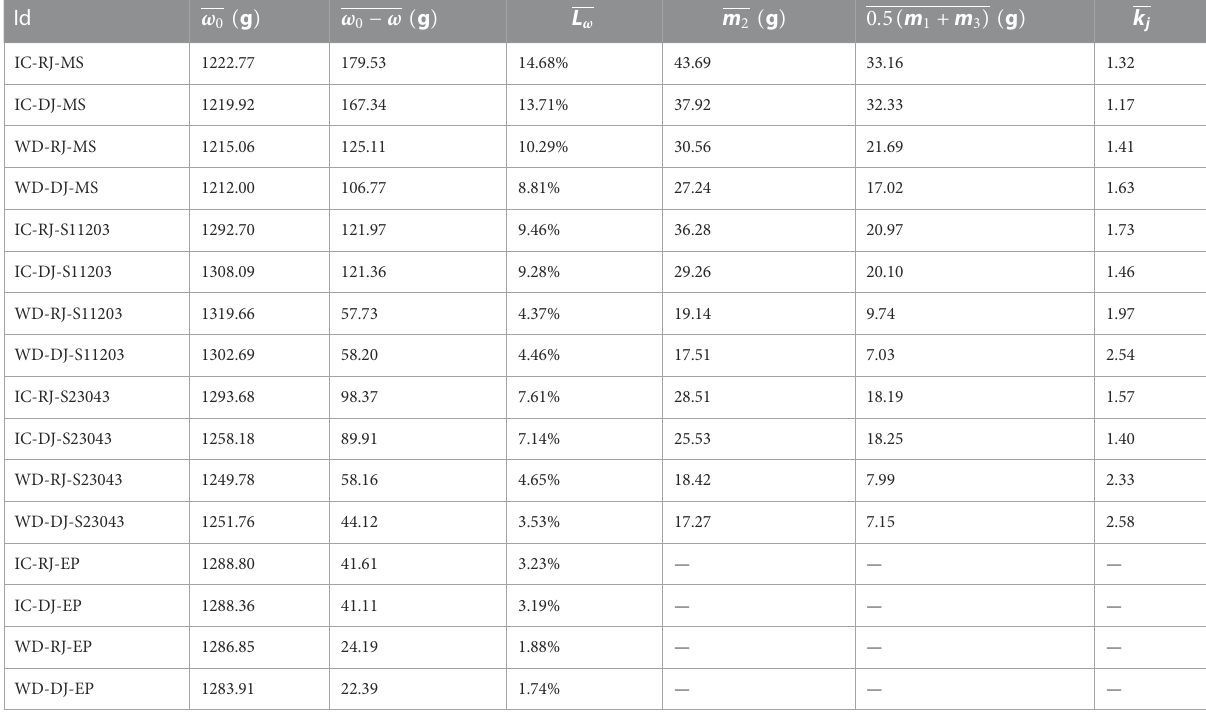
TABLE 4 Weight loss and